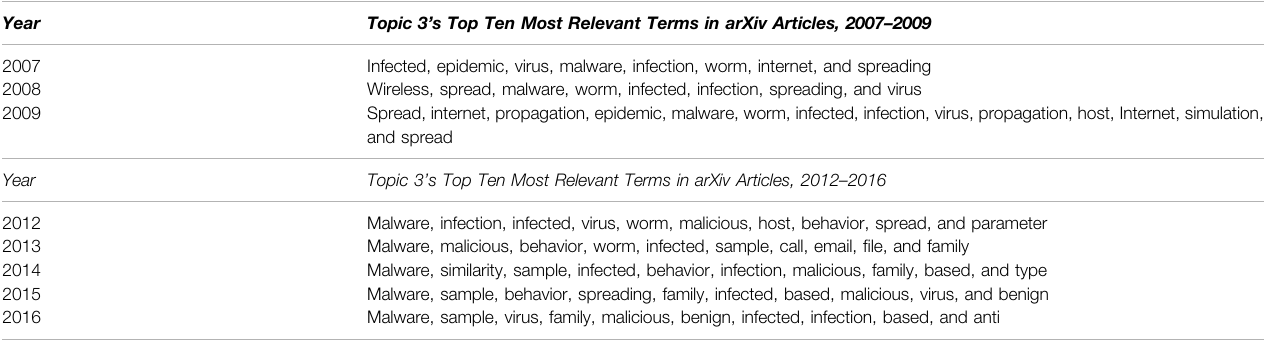
TABLE 8 | 100-topic arXiv Cryptography and Security research articles of the dynamic topic model topic 3 for years 2007 – 2009 and 2012 –